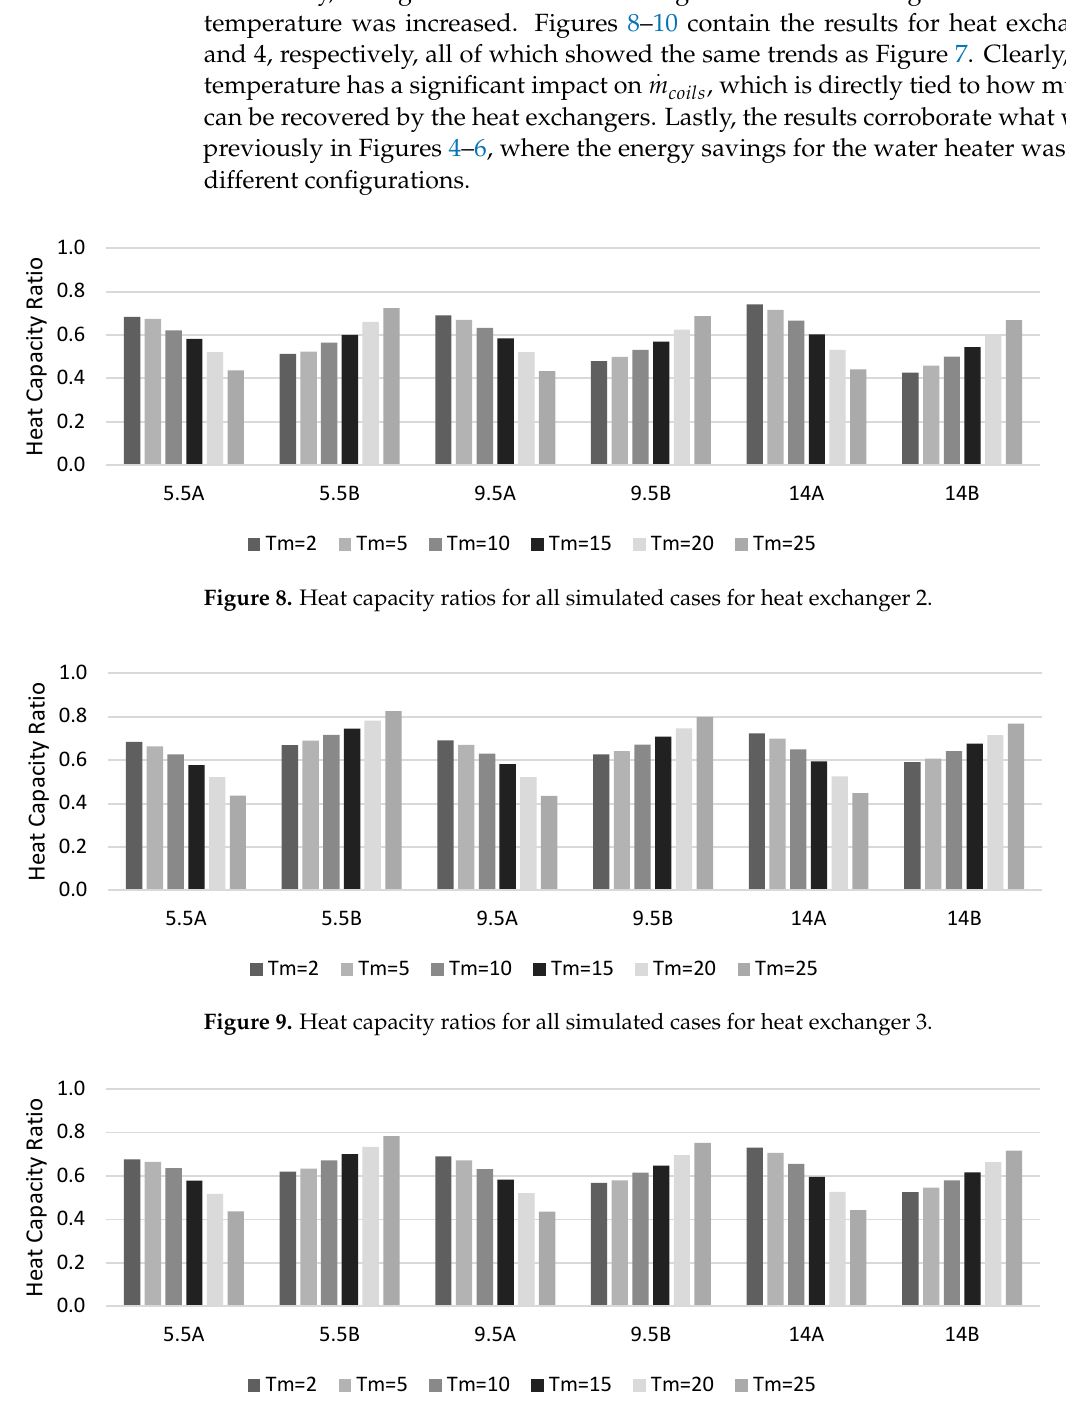
Figure 10. Heat capacity ratios for all simulated cases for heat exchanger 4.